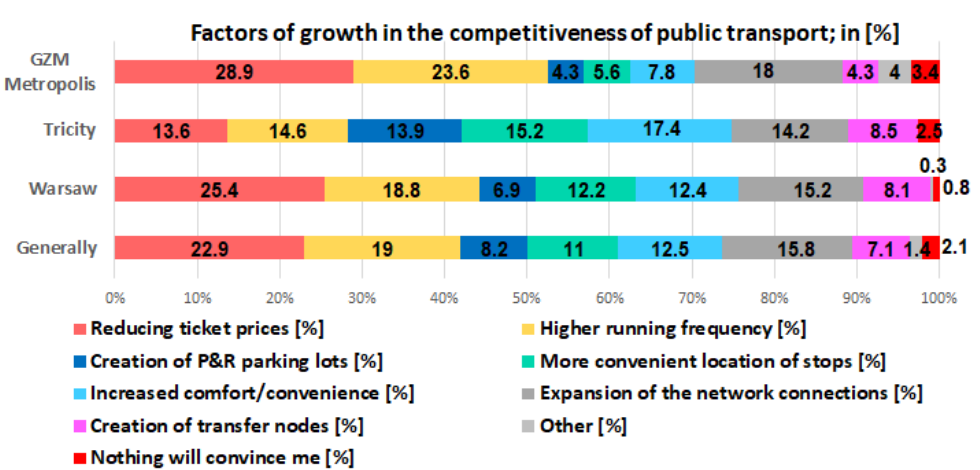
Figure 3. Factors of growth in the competitiveness of public transport. Source: based on [3].